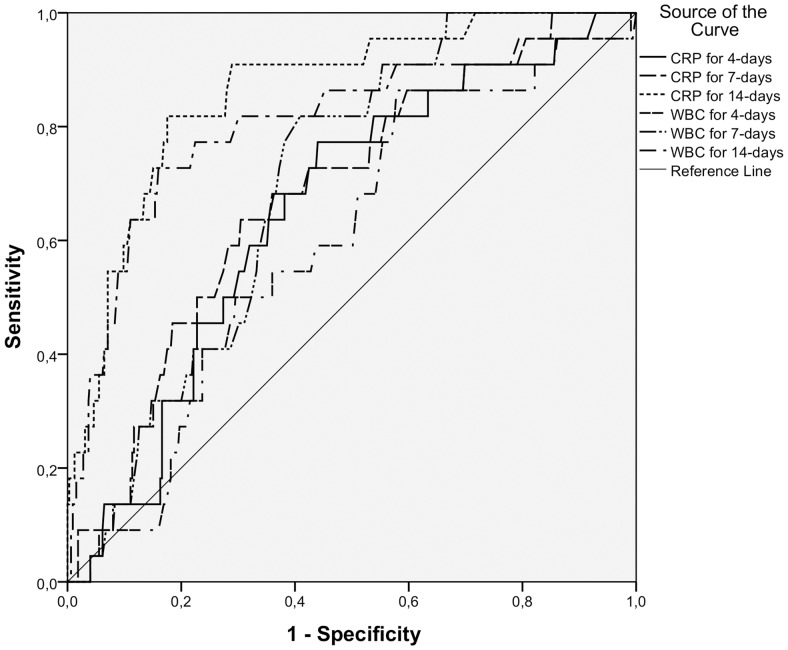
Receiver-operating characteristic (ROC) curve analyses of C-reactive protein (CRP) concentrations and white blood cell counts (WBC) with respect to 30-day mortality in Staphylococcus aureus bacteremia (n = 430).The area under the curve (AUC) for CRP on the day 4 was 0.65 (95% CI, 0.55–0.76; p = 0.016) with a cut-off value of 104 mg/L with sensitivity of 77% and specificity of 55%. For CRP on the day 7 the AUC was 0.68 (95% CI, 0.58–0.79; p = 0.004) with a cut-off value of 66 mg/L with sensitivity of 73% and specificity of 55% and for CRP on day 14 the AUC was 0.86 (95% CI, 0.79–0.94; p<0.0001) with a cut-off value of 61mg/L with sensitivity of 82% and specificity of 80%. The corresponding AUC for WBC on the day 4 was 0.60 (95% CI, 0.49–0.71; p = 0.116) with a cut-off value of 8.0 x109/L with sensitivity of 86% and specificity of 41%. For WBC on the day 7 the AUC was 0.70 (95% CI, 0.62–0.78; p = 0.002) with a cut-off value of 9.8 x109/L with sensitivity of 77% and specificity of 62%. For WBC on the day 14 the AUC was 0.80 (95% CI, 0.70–0.92; p<0.0001) with a cut-off value of 8.6 x109/L with sensitivity of 77% and specificity of 78%.